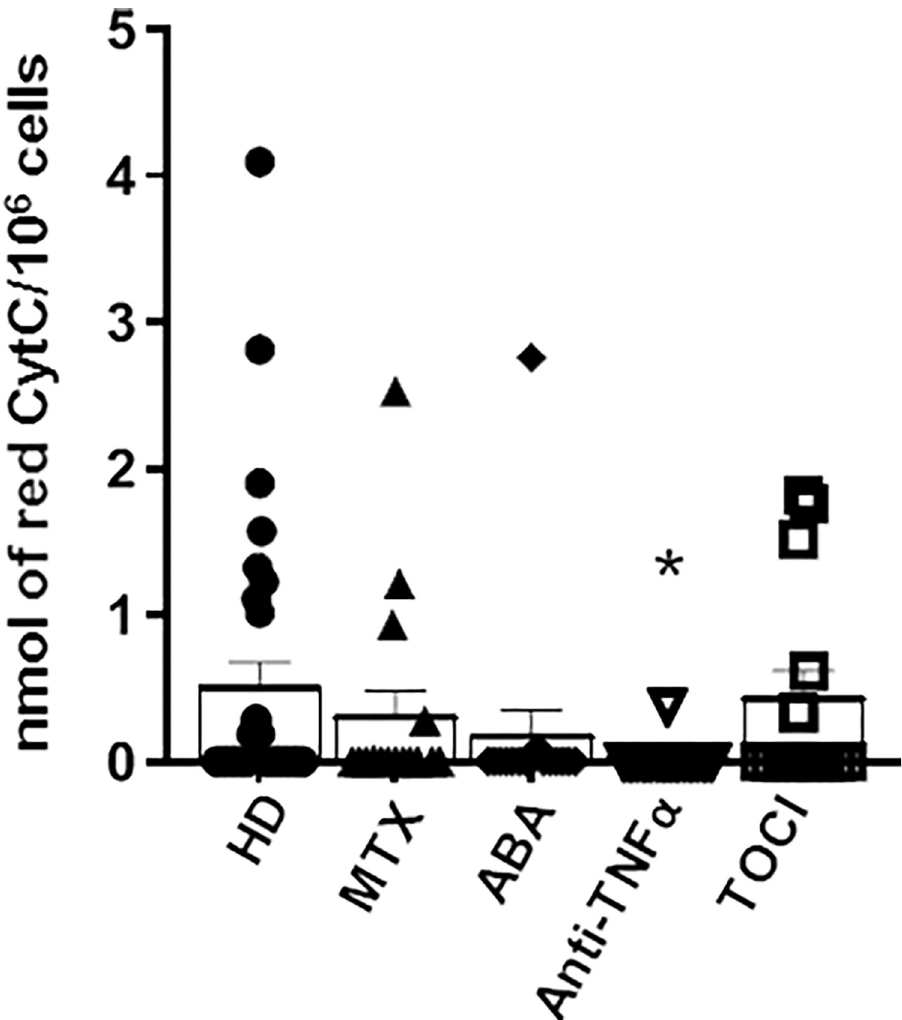
donors (n = 30 healthy control, n = 15 each group of RA patients), analysed by analysed by one-way ANOVA with Dunnett’s test for multiple comparisons. � p -value < 0.05 versus healthy donors (HD). MTX, methotrexate; ABA, abatacept; TOCI,